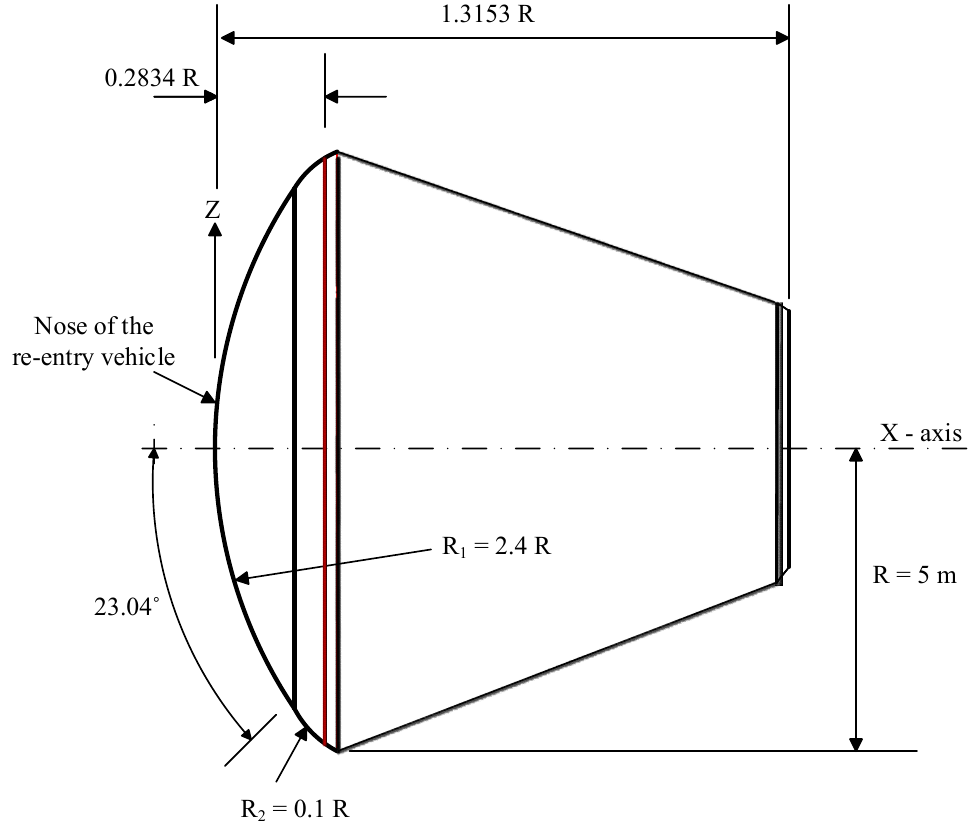
Figure 1. Schematic sketch of the Orion model (dimensions as in [33]), for which the nose shell structure is considered.